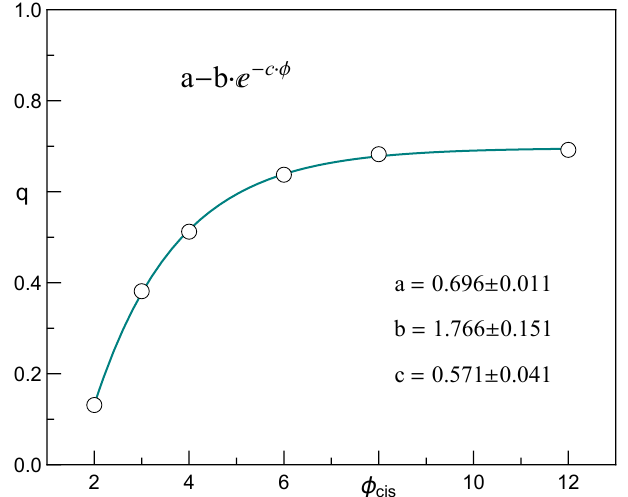
Figure 2. Fraction q of successful capture events: open circles—data points; green line—the best fit. The errors indicate 95% confidence